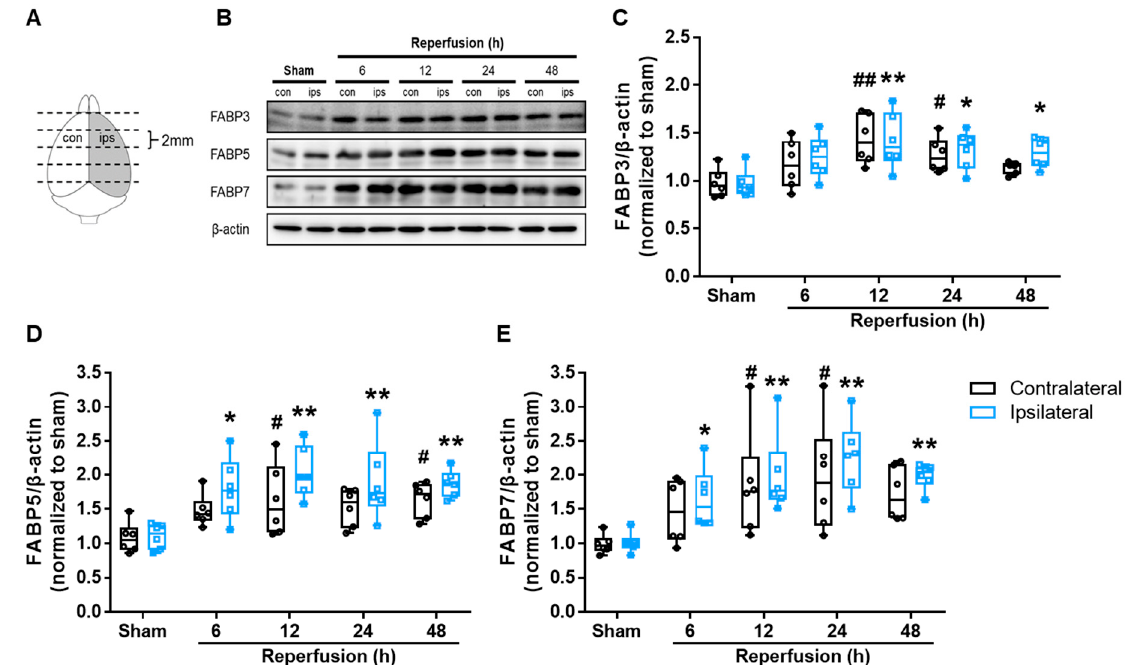
Figure 4. Effects of I/R injury on FABP3, FABP5 and FABP7 expression levels in the brain. ( A ) The locations of samples. Brains were cut into four slices (2-mm thick) from the front of the cortex. The second slices (designated as con and ips slices) of the brain, including the cortex and striatum, were used for Western blot analysis and PGE 2 -content analysis in the following experiments. ( B – E ) Mice were subjected to right tMCAO for 2 h. At 6, 12, 24 and 48 h after reperfusion, the second slice of the right brain (ipsilateral) and the left brain (contralateral) areas were collected for Western blot analysis of FABPs levels. ( B ) Representative images of Western blots. Quantitative analyses of FABP3 ( C ), FABP5 ( D ) and FABP7 ( E ) expression levels in contralateral (black) and ipsilateral (blue) areas of the brains. # p < 0.05, ## p < 0.01 vs. the sham group (contralateral); * p < 0.05, ** p < 0.01 vs. the sham group (ipsilateral) (n = 6 per group). Differences were statistically analyzed using one-way analysis of variance (ANOVA) followed by Dunnett’s test.